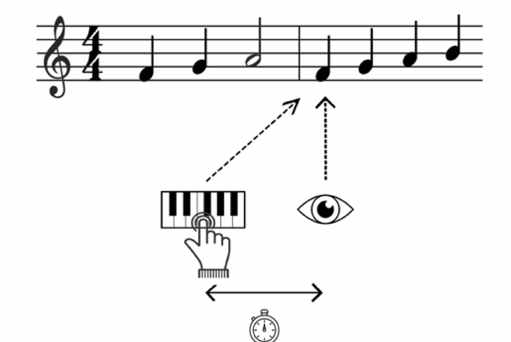
Figure 4. Representation of EHS measured in absolute time